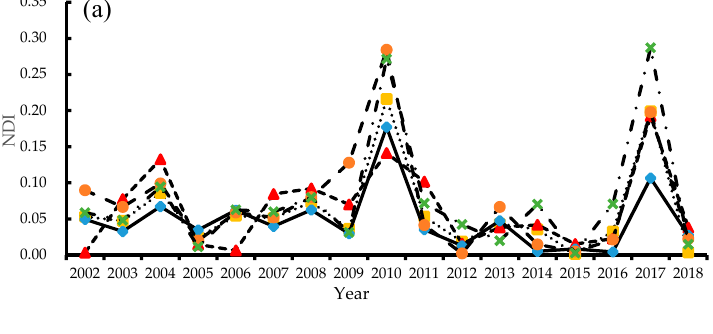
Figure 4. TNL data comparison under different correction methods, Nationwide ( ■ ), Northeastern ( ▲ ), Eastern ( ◆ ), Central ( ● ), Western (×); ( a ) uncorrected; ( b ) corrected in this article; ( c ) reference correction method.